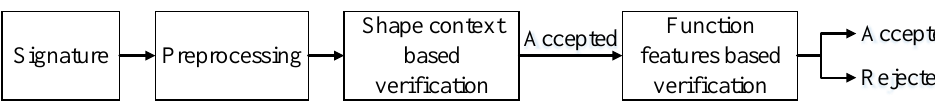
Figure 1. Diagram of proposed verification